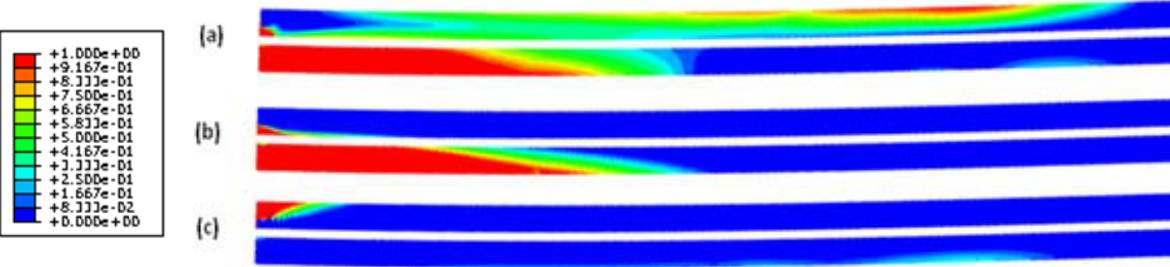
; ( b ) star-shaped damage 11